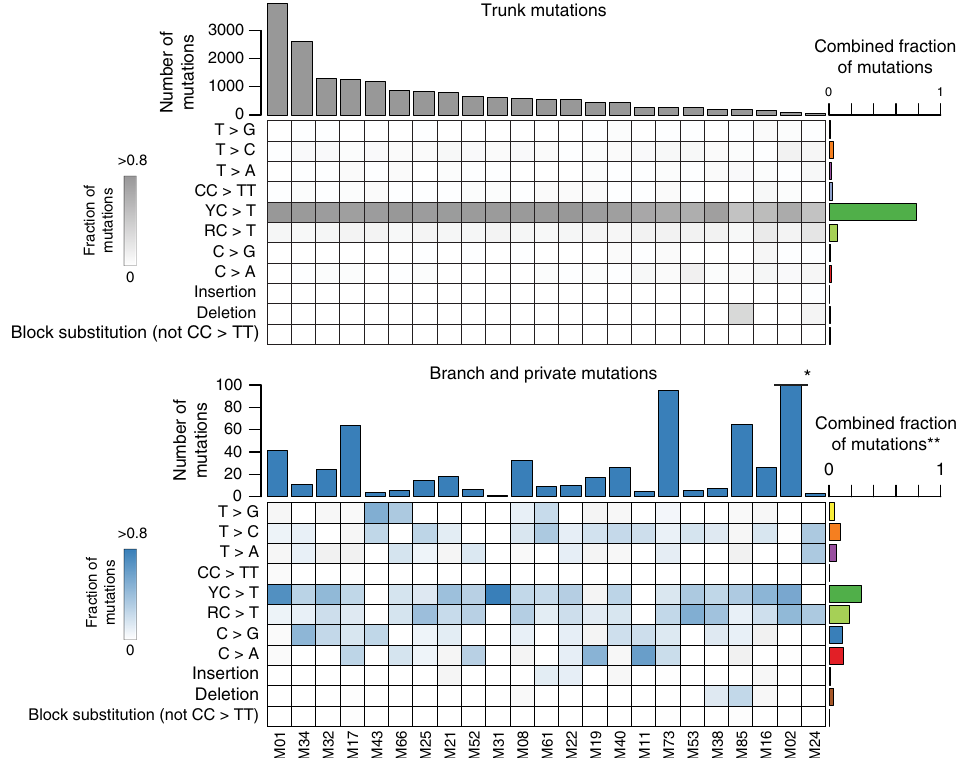
Fig. 3 Comparison of trunk and branch mutations. Heatmaps show the relative frequency of mutations among branch mutations (top panel; gray) and branch mutations (bottom panel; blue) for each patient. C>T transitions are categorized as occurring downstream of pyrimidines (Y) or purines (R). The combined fractions of mutations represent the sum of mutations for each type relative to the total number of mutations for either trunk or branch mutations. * Due to the high number of branch mutations in MM02 ( n = 1786), the bar is truncated for this patient. ** In the summary of branch mutation types, mutations in MM02 are omitted for clarity (branch mutations in MM02 displayed a particular mutational signature; see Supplementary Fig. 7 and 11 for